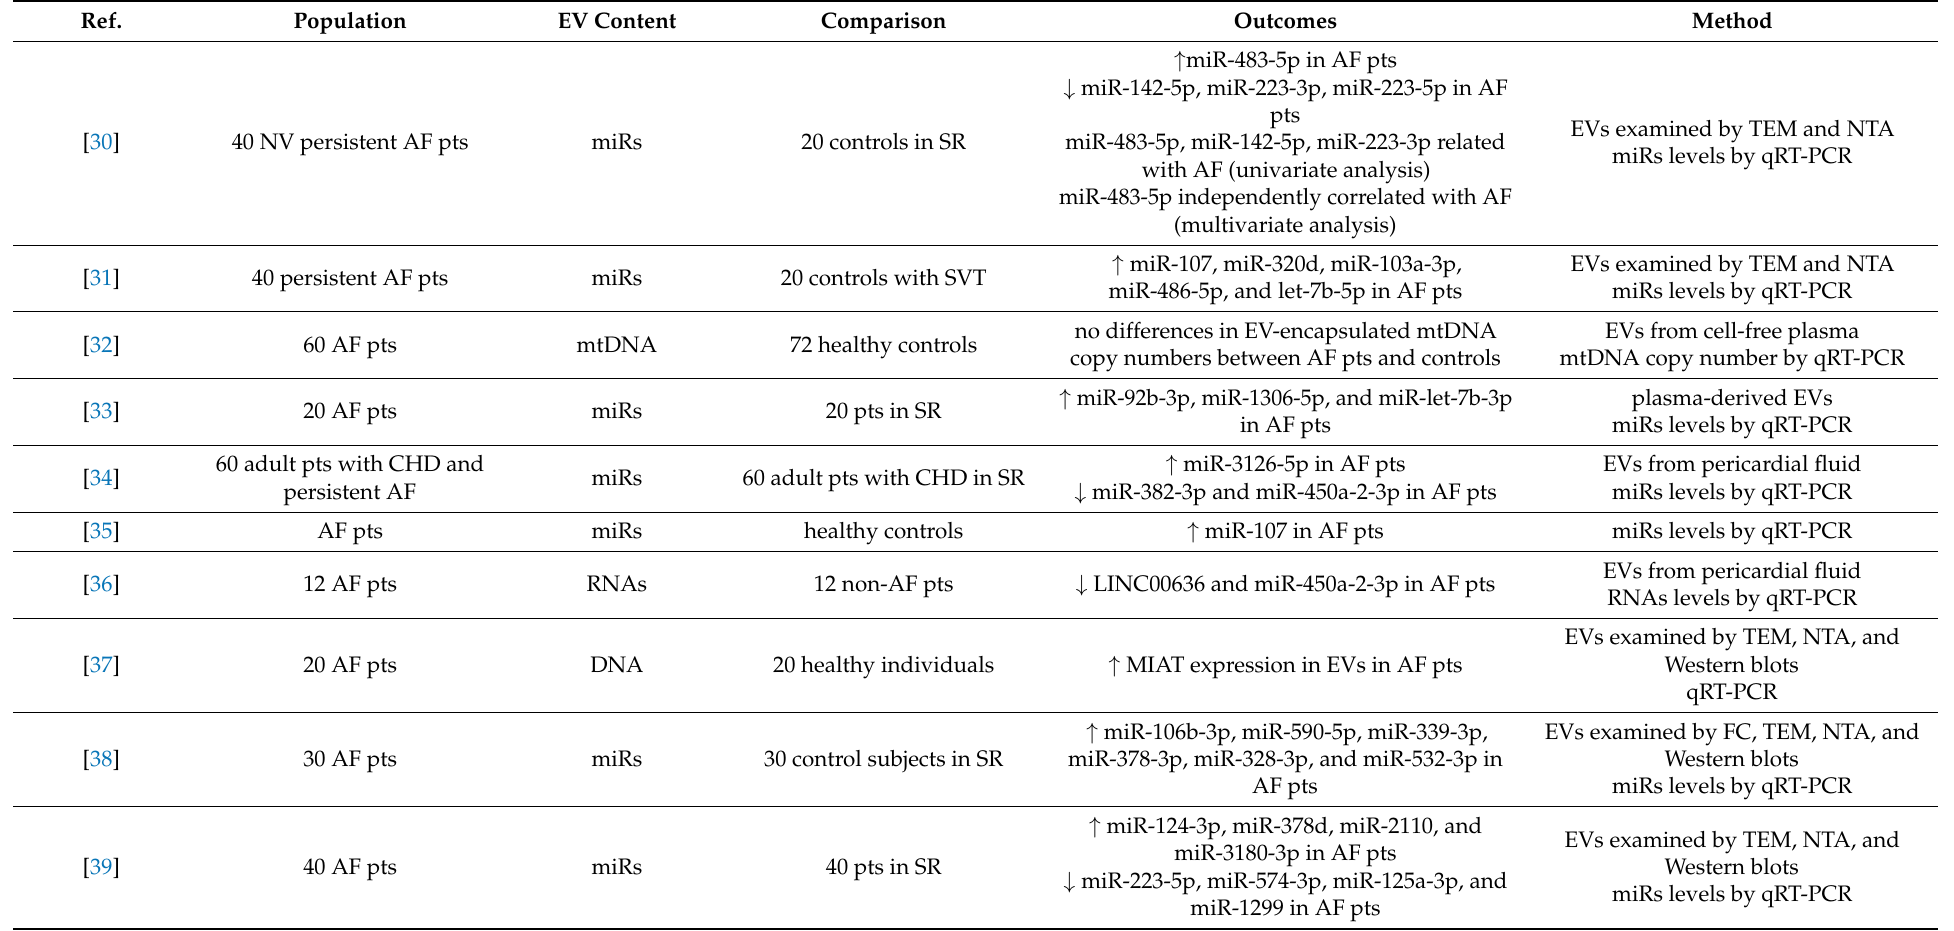
Table 2. Summary of recent studies concerning extracellular vesicles containing nucleic acids in atrial fibrillation patients.